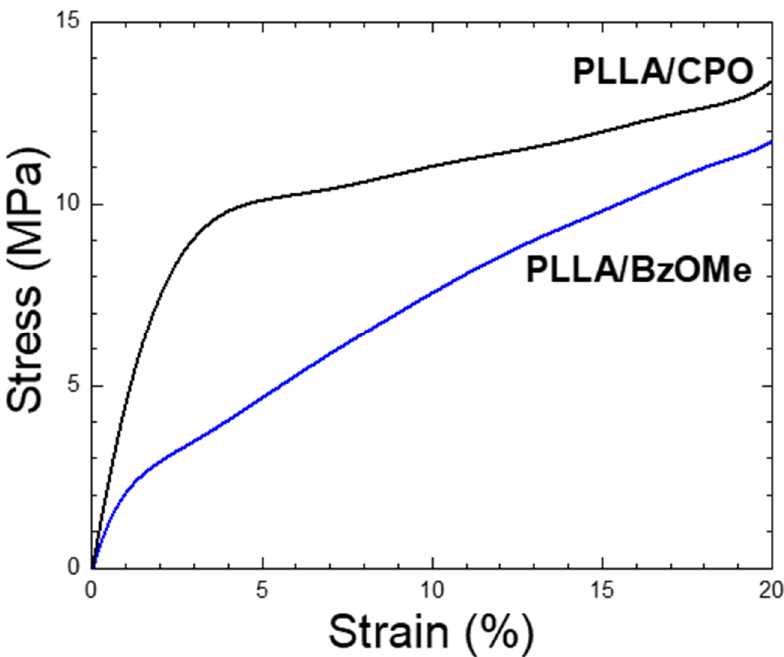
Figure 6. Stress–strain curves by compressive tests of PLLA/CPO and PLLA/BzOMe porous scaf- folds, with different porosity and pore morphologies. Each curve is the average of five specimens.